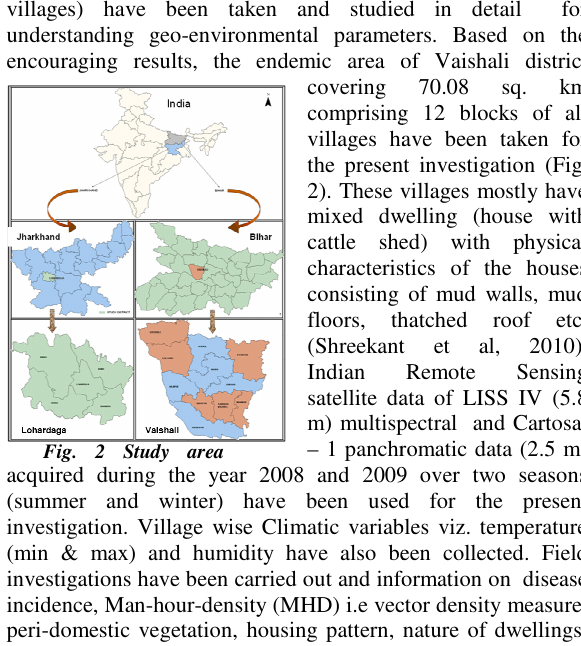
Fig.4 Overall M Satellite data processing : IRS LISS satellite data pertaining to two seasons have been rectified reference maps and the study area has been extracted. Different digital enhancement techniques like linear enhancement, histogram equalisation etc. have been applied on the satellite data. IRS LISS I V and CARTOSAT using Brovey transform to increase interpretability. two seasons satellite data. False Normalised Difference Vegetation index the study area (fig.5). Normalised Difference Vegetation index has been performed to assess the vegetation vigour of the